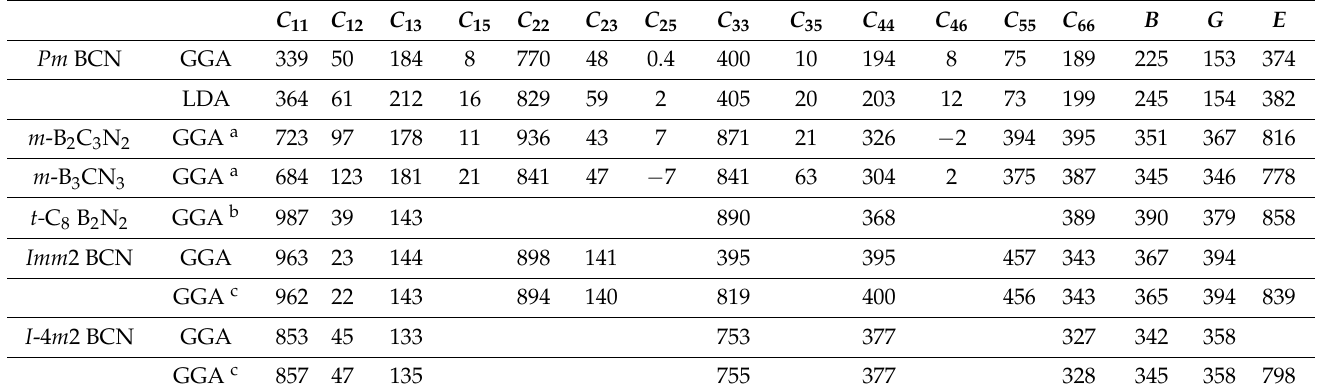
Table 2. Calculated elastic constants (GPa) and elastic moduli (GPa) of Pbca XN, Imm 2 BCN, and Figure 2. Phonon spectra of Pm -BCN ( a ) and the relative enthalpies of B-C-N compounds ( b ). Young’s modulus E is calculated by E = 9 BG /(3 B + G ), and Table 2 lists the calculated